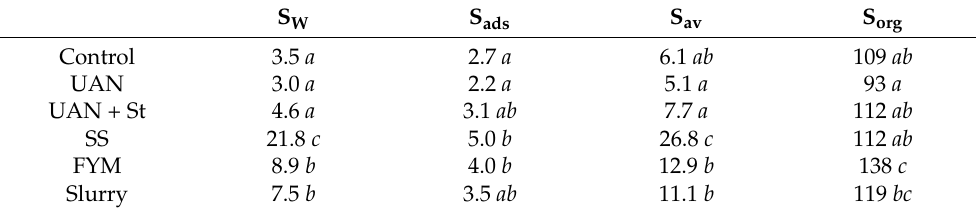
Table 10. The content of sulfur fractions in subsoil (mg S kg − 1 ) in the year 2019.